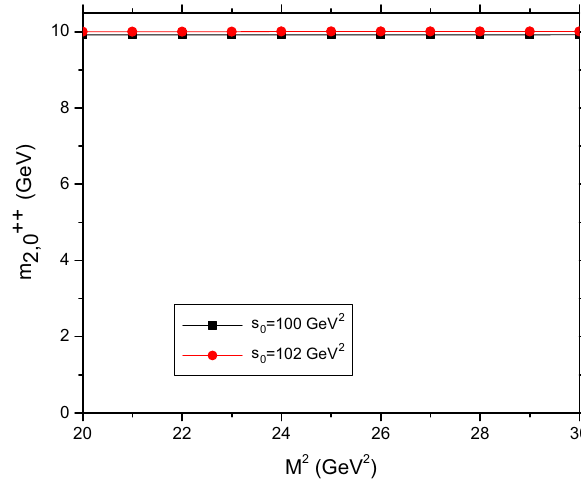
Fig. 7 Borel parameter dependence of J PC = 2 ++ meson mass from (cid:10) ( 2 ) μναβ for different s 0 values